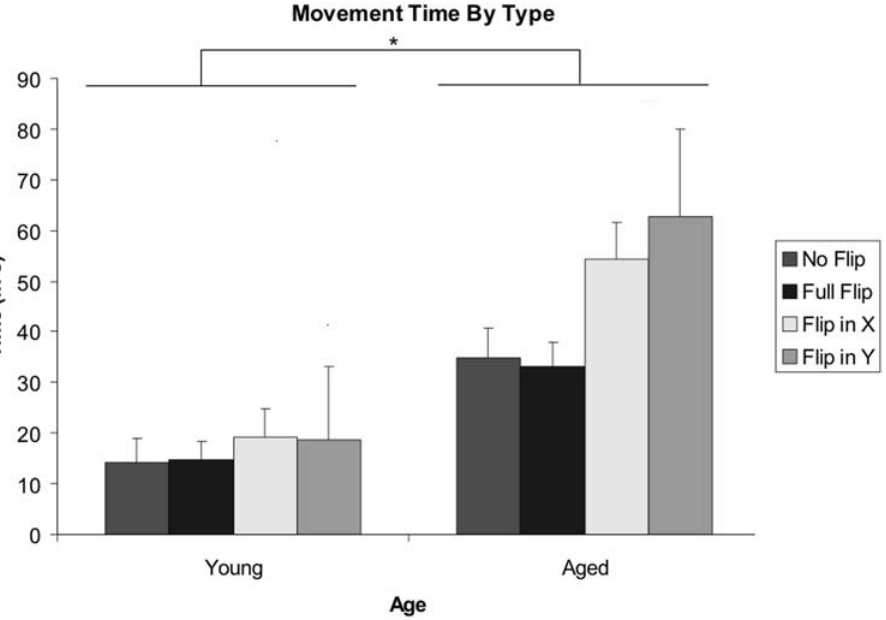
Figure 5. Average Movement Times. Overall, aged participants spent more time scanning the presented object when compared to the younger controls. Additionally, aged participants displayed a comparatively larger effect of both a flip in the X-Axis, and a flip in the Y-Axis, when compared to younger control participants, as evidenced by the significant Visuomotor Flip X Age interaction. Error bars represent the standard error of the mean. . *p , 0.05 indicates a significant difference.